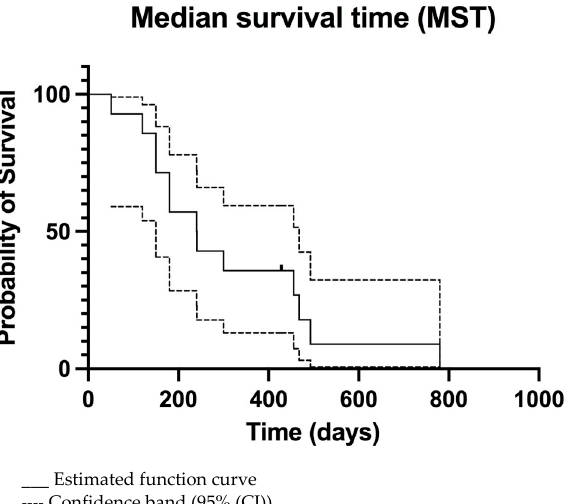
Figure 3. Kaplan ‐ Meier median survival time (MST) curve of all dogs. The only censored patient is marked.